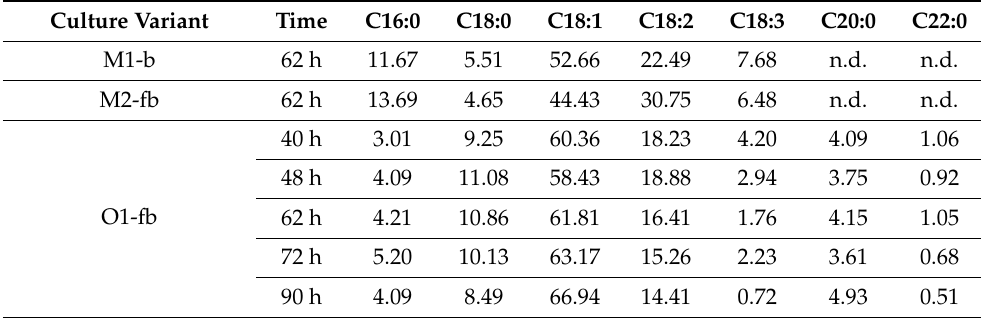
Table 2. The fatty acids profile (%) of microbial lipids extracted from biomass cultured in M1-b, M2-fb and O1-fb